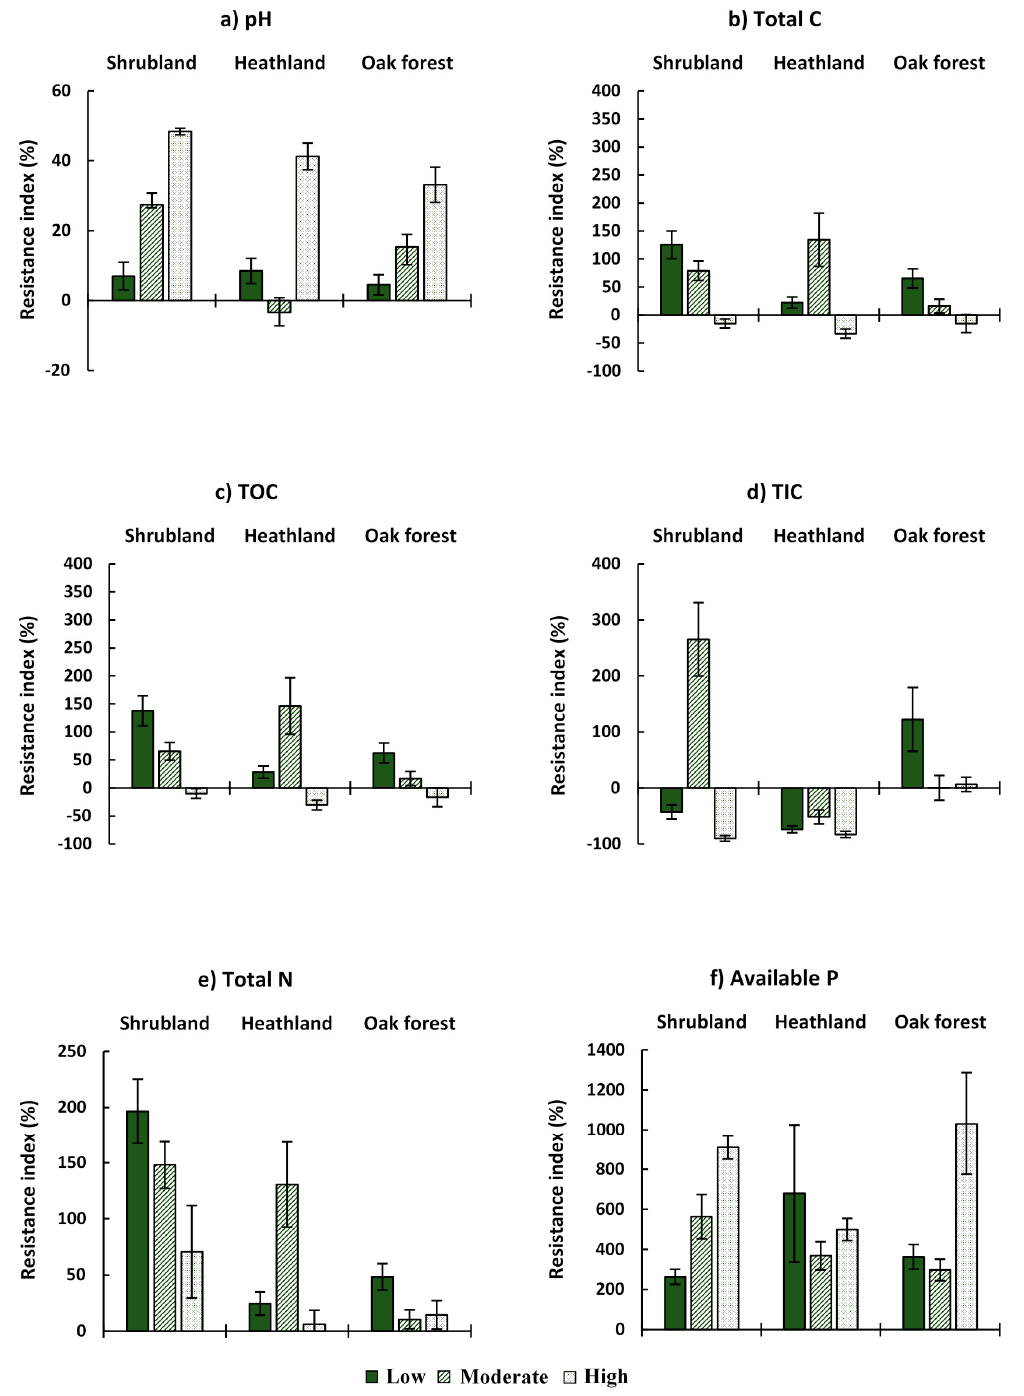
Figure 3. Average of ( a ) pH, ( b ) total C, ( c ) total organic carbon (TOC), ( d ) total inorganic carbon (TIC), ( e ) total N, and ( f ) available P resistance index values and standard error for each forestry ecosystem (shrubland, heathland, and oak forest) and burn severity level (low, moderate, and high) measured by the Composite Burn Index (CBI).